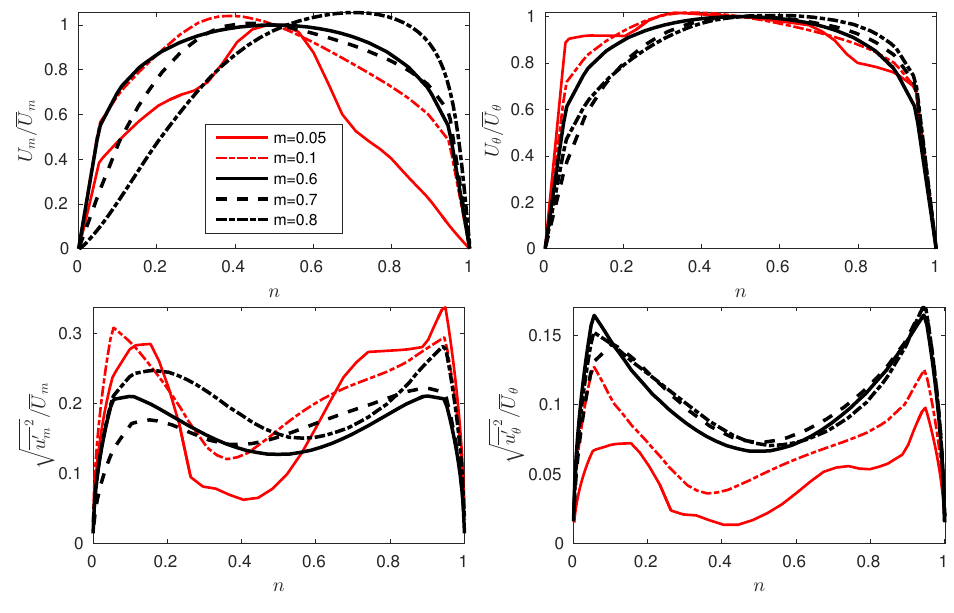
Figure 5. Profiles of the time-averaged meridional and tangential velocity components for flow angle α IN = 9.5 ◦ for different locations along the meridional indicated in the figure. Profiles of mean meridional and tangential velocity fluctuation intensity are shown in the bottom row. Profiles are scaled with the mean local